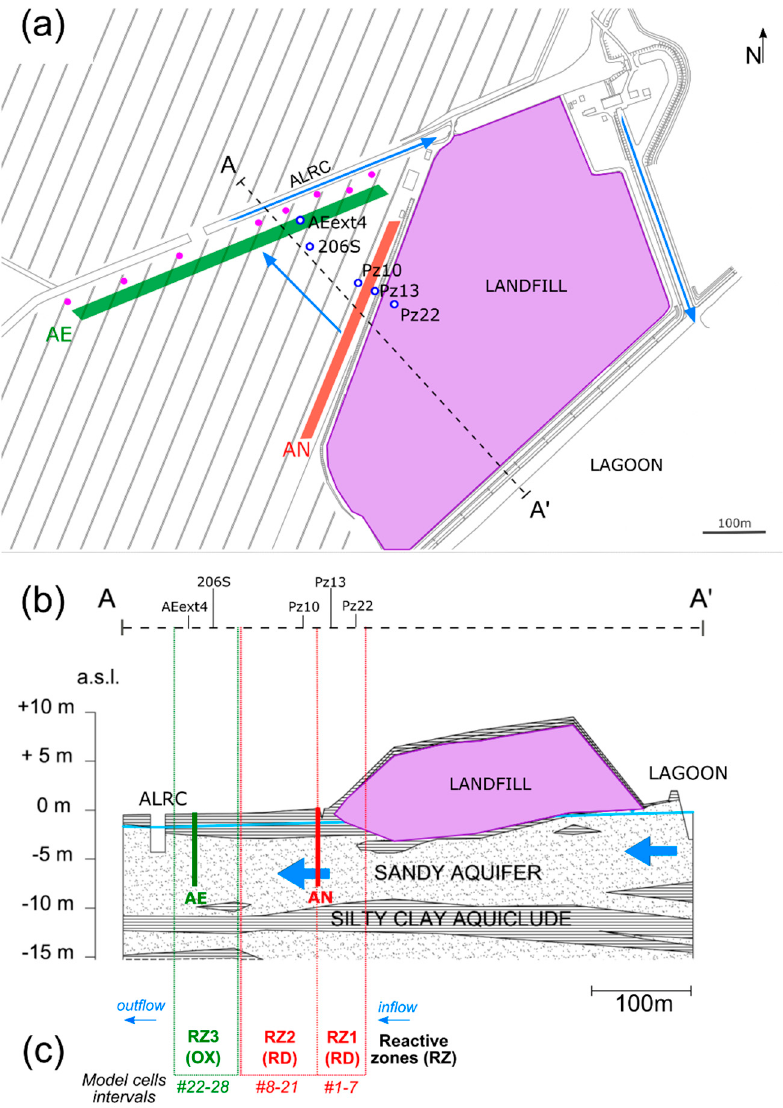
Figure 1. ( a ) Map of the study area, showing the landfill (lilac area) and the position of the ISB systems (AN—anaerobic barrier, AE—aerobic barrier) and the five boreholes utilized in the analysis. The wells of the P&T system are represented as purple dots. ( b ) Schematic geological cross-section of the study area (corresponding to the A–A’ trace indicated in ( a )), highlighting the top aquifer (first 10–12 m from the ground surface). The vertical axis represents the topographic elevation above sea level (a.s.l.). The blue arrows indicate the groundwater flow direction, which was oriented from the lagoon in the southeast to the agricultural land reclamation canal (ALRC) in the northwest. ( c ) Conceptual scheme of the PHREEQC model, highlighting the three reactive zones defined by the corresponding cell intervals. In RZ1 and RZ2, reactions were mainly controlled by reductive dechlorination (RD), while in RZ3, oxidation (OX) prevailed.